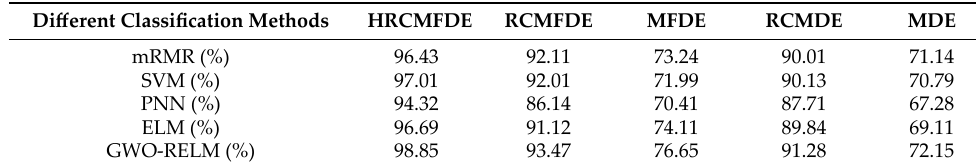
Table 10. Comparison of models under different classification methods.